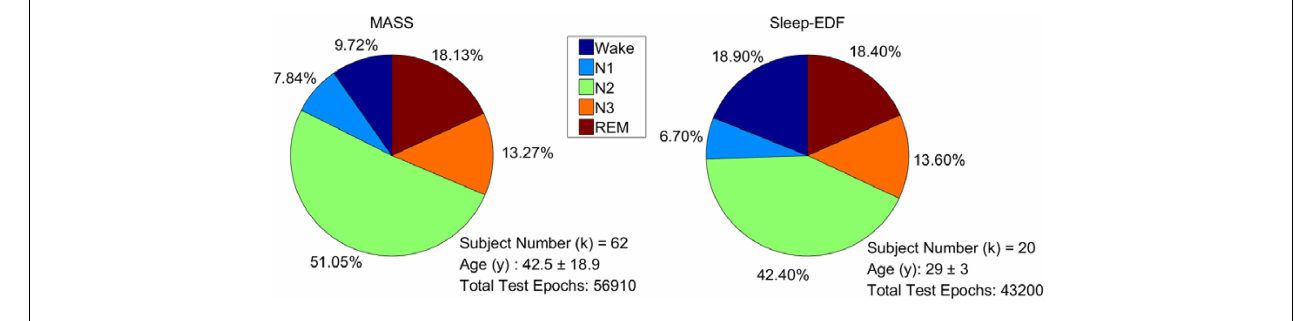
FIGURE 6 | The data distribution of the MASS and Sleep-EDF